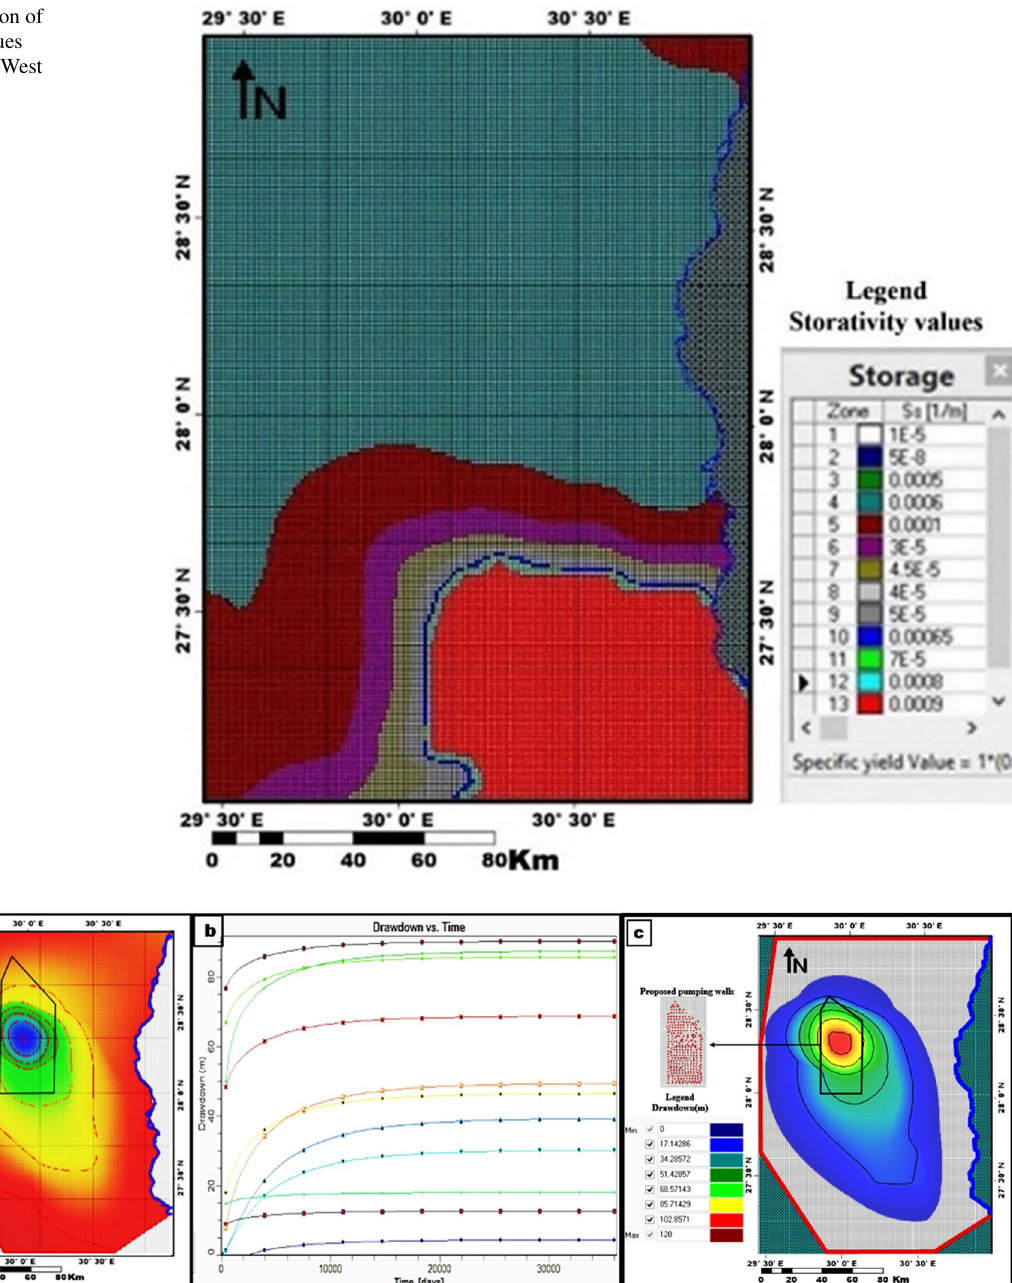
Fig. 15 Spatial distribution of calibrated storativity values in Eocene aquifer, West–West Minya area